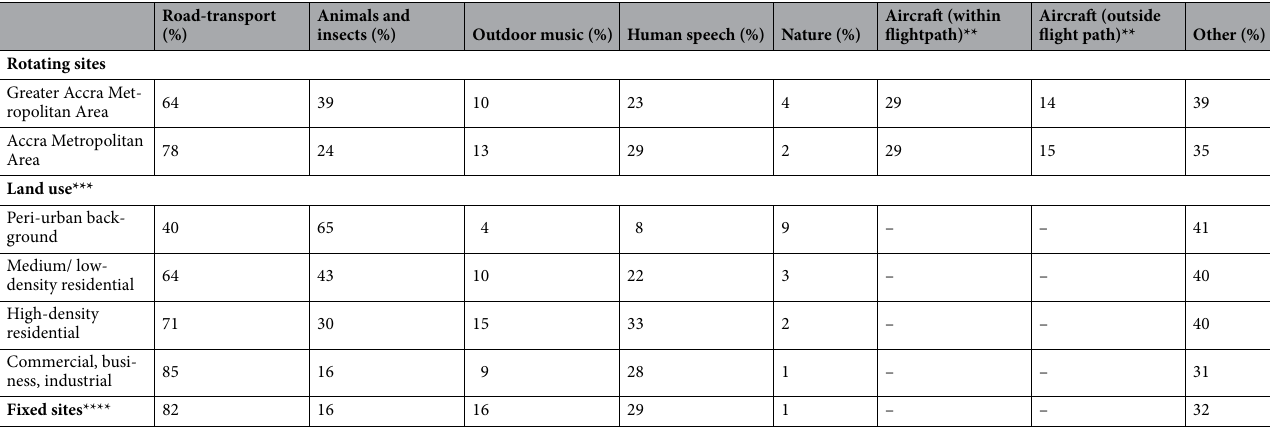
Table 2. Detection of sound source prevalence across land use areas in the Greater Accra Metropolitan Area*. Data are expressed as the percentage (%) of site-time present. *The top three sound classes based on modelled probability of presence were retained for each 10-s audio clip. **Within/outside of 1 km of take-off/descent flight path for Kotoka airport (n = 7 rotating and n = 1 fixed site near flight path). ***Medium/low-density residential are typically formal residential areas; high-density residential are typically informal residential areas and could be classified as shantytowns or slums; peri-urban background are the least built-up areas and typically have an abundance of forest, grass land, shrubs, barren land, and/or water; commercial, business and industrial areas are places which are dominated by commercial, business, industrial, and/or government activities (see full criteria in S8). *** 9 fixed sites had 3 CBI areas along major motorways, 2 sites in high- density residential neighborhoods, 3 sites in medium/low-density residential areas and one at a peri-urban location.